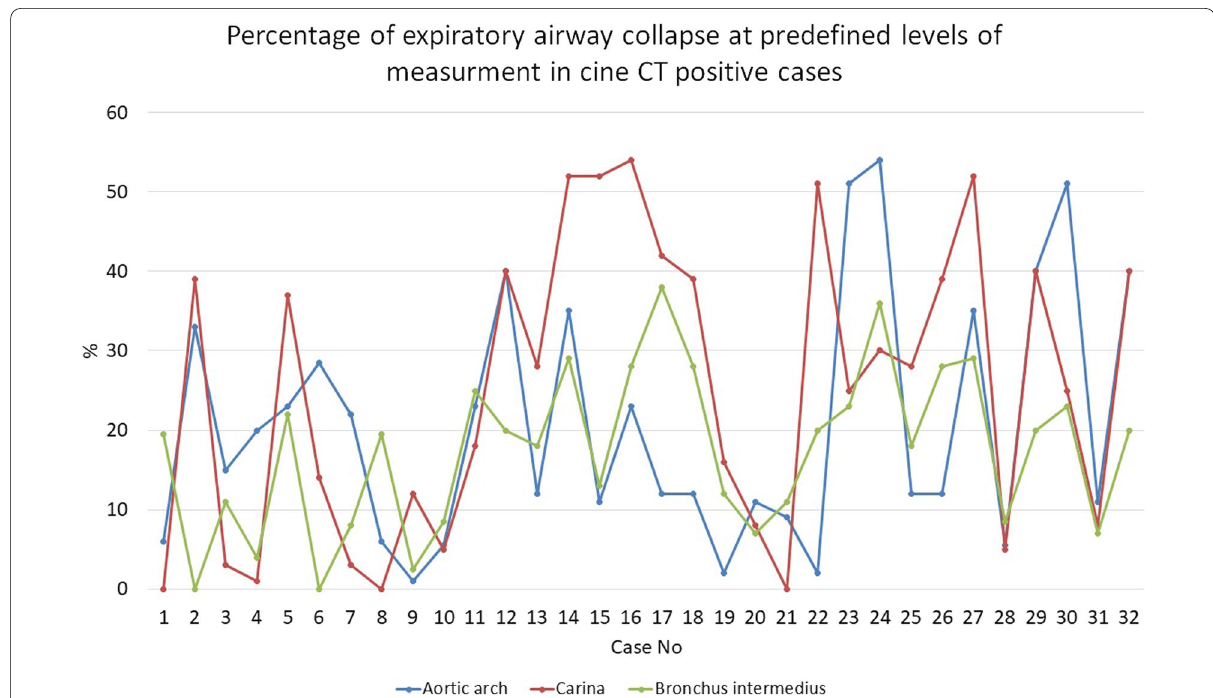
Fig. 5 Percentage of expiratory central airway collapse at the three predefined locations of cross-sectional area measurement. The degree of expiratory central airway collapse was higher at carina in most of cases compared to other levels of